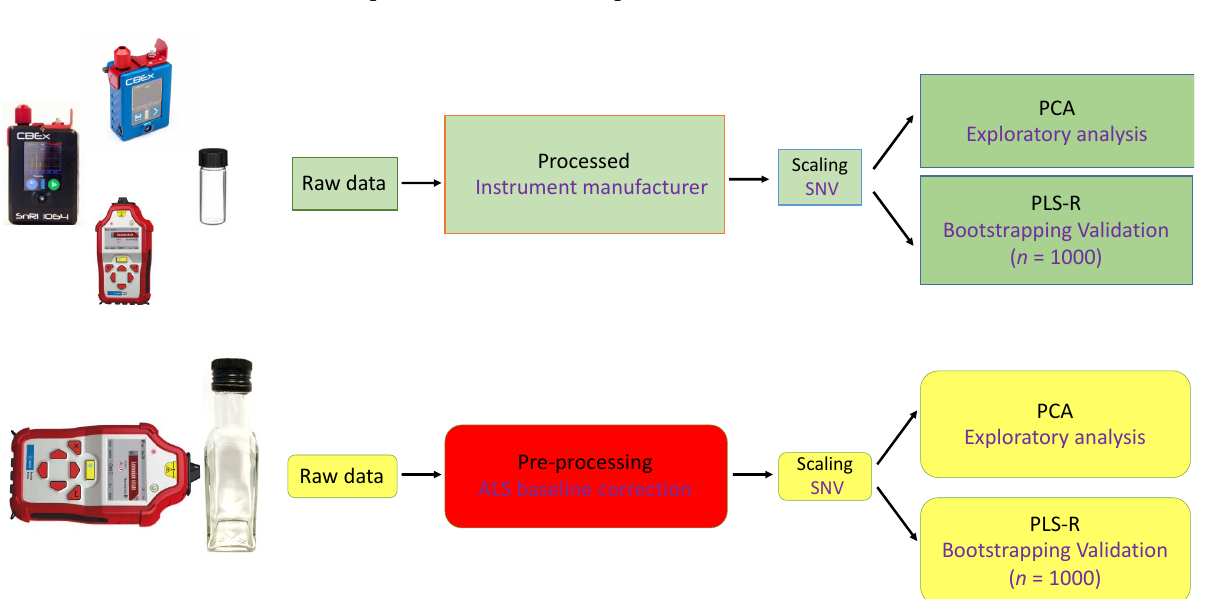
Figure 1. General flow diagram showing the overall data analysis pipeline for the handheld Raman methods in vial mode, as well as handheld SORS for through-container analysis. The Raman spectrometers are not to scale. Abbreviations used: ALS, asymmetric least squares; PCA, principal components analysis; PLS-R, partial least squares regression; SNV, standard normal variate. For bootstrapping validation n = 1000 resamplings were made.